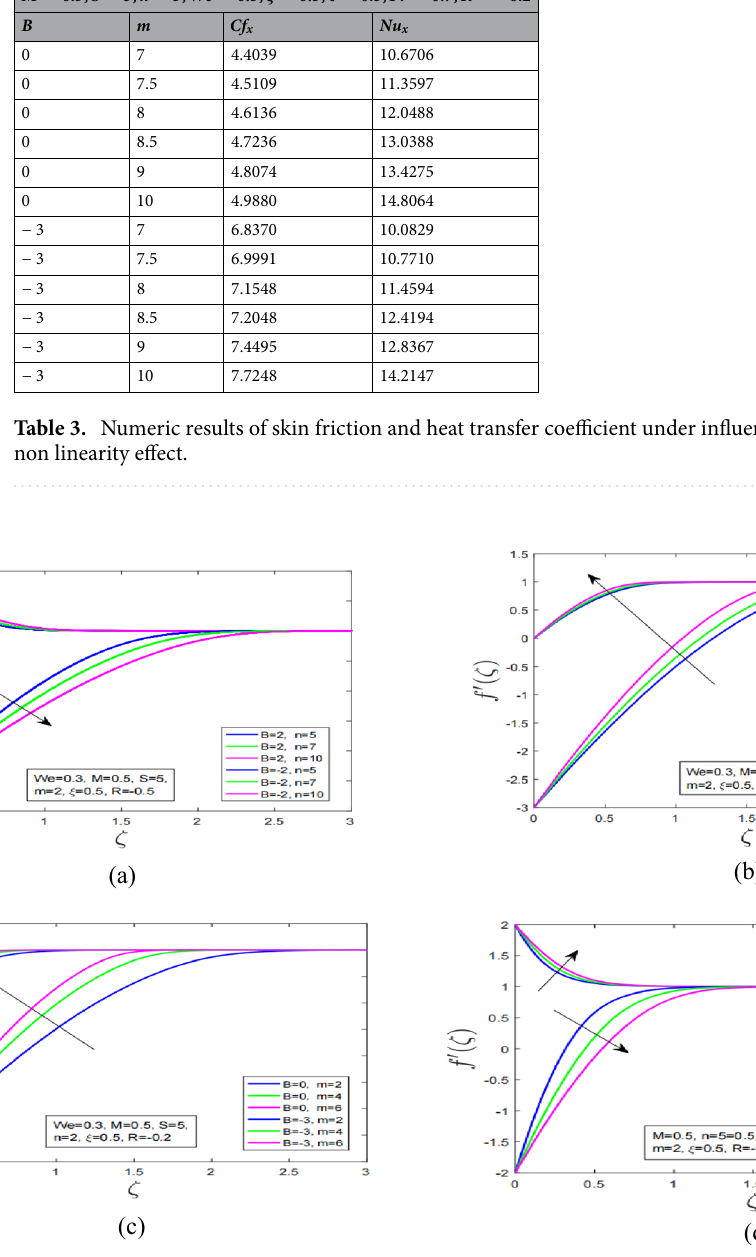
′ . ( c ) Non-linearity impression on f